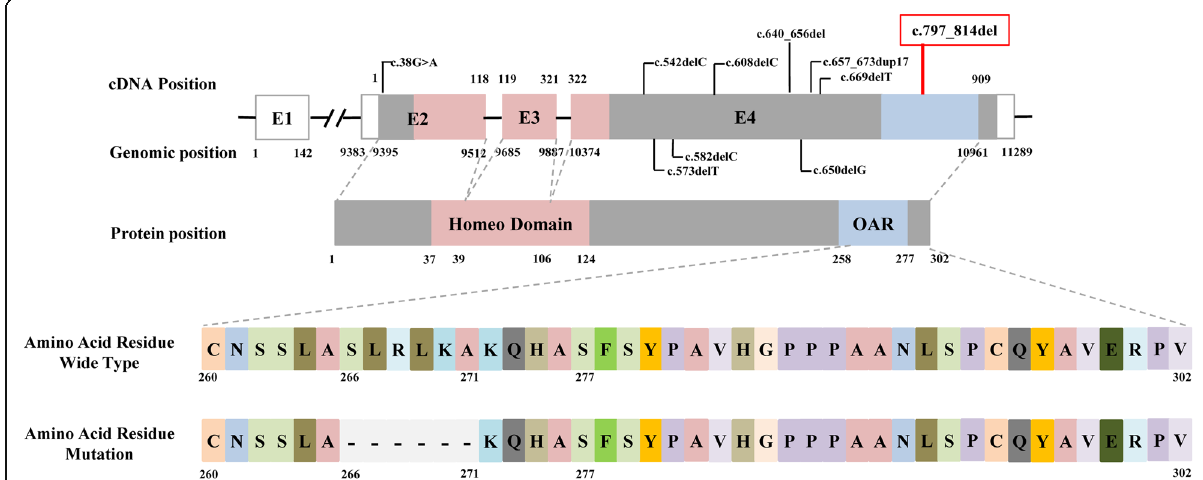
Fig. 4 Diagrammatic representation of the PITX3 gene, domains of the PITX3 protein, positions of mutations and amino acid residues. Human PITX3 consists of four exons (E1-E4) and contains two functional domains: the homeobox domain and the OAR domain. Exons 2 through 4 in PITX3 encode the PITX3 protein; exons 2 through 4 encode the homeodomain (pink), and exon 4 encodes the OAR domain (blue). Nine reported causal mutations associated with congenital cataract that have been identified in independent studies are indicated in black; none of these mutations is located in the functional domain. The deletion mutation c.797_814del, p.(Ser266_Ala271del) identified in this research, which is indicated using a red box, is located in the OAR domain-encoding region. This mutation will result in a deletion of 6 amino acid residues at codons 266 to 271 at the C-terminus of the